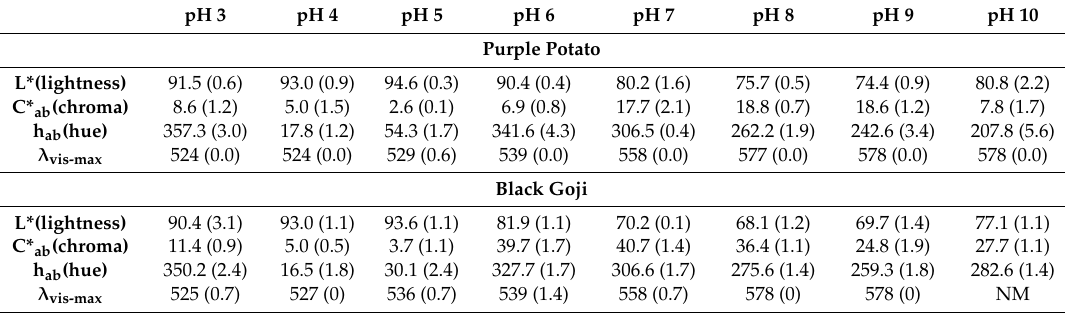
Table 1. Colorimetric (CIE-L*, C* ab , h ab ) and spectrophotometric ( λ vis-max ) data of purple potato and black goji anthocyanin extracts over pH 3–10. Data are presented as means ( n = 3) followed by standard deviations (in parentheses). NM: not measurable due to color